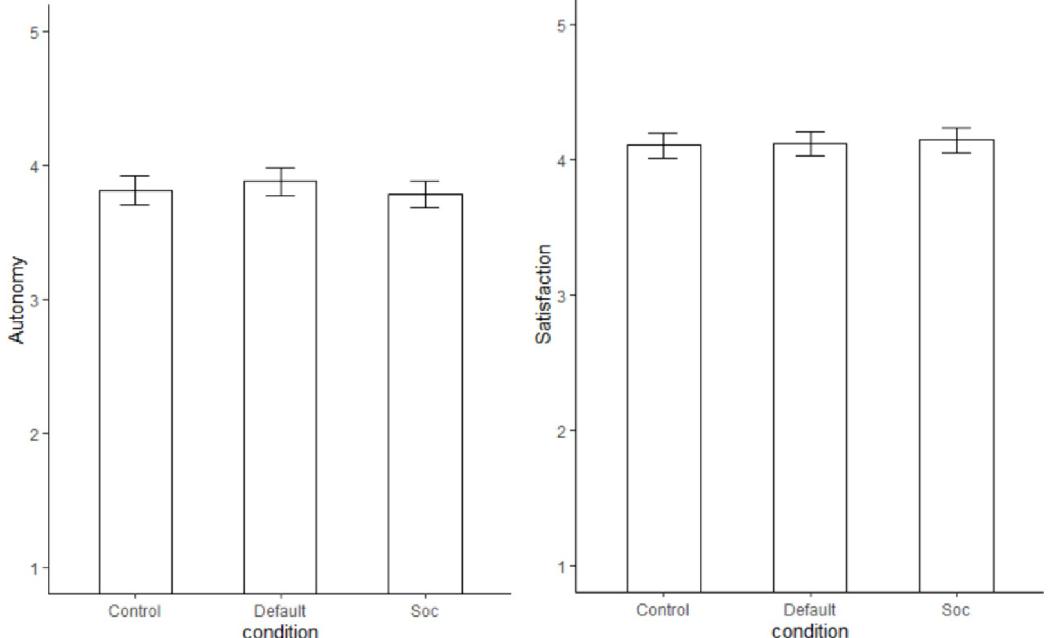
Fig 2. Means and standard errors for autonomy and